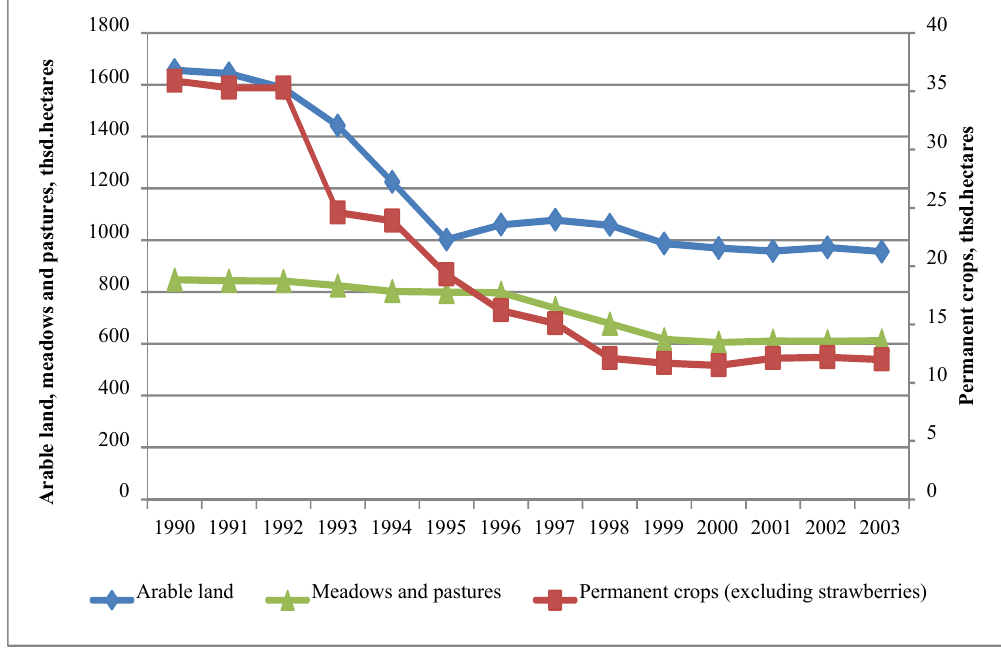
Fig. 3. Use of agricultural area (thsd. hectares) (made by the authors, using the Central Statistical Bureau of Latvia,